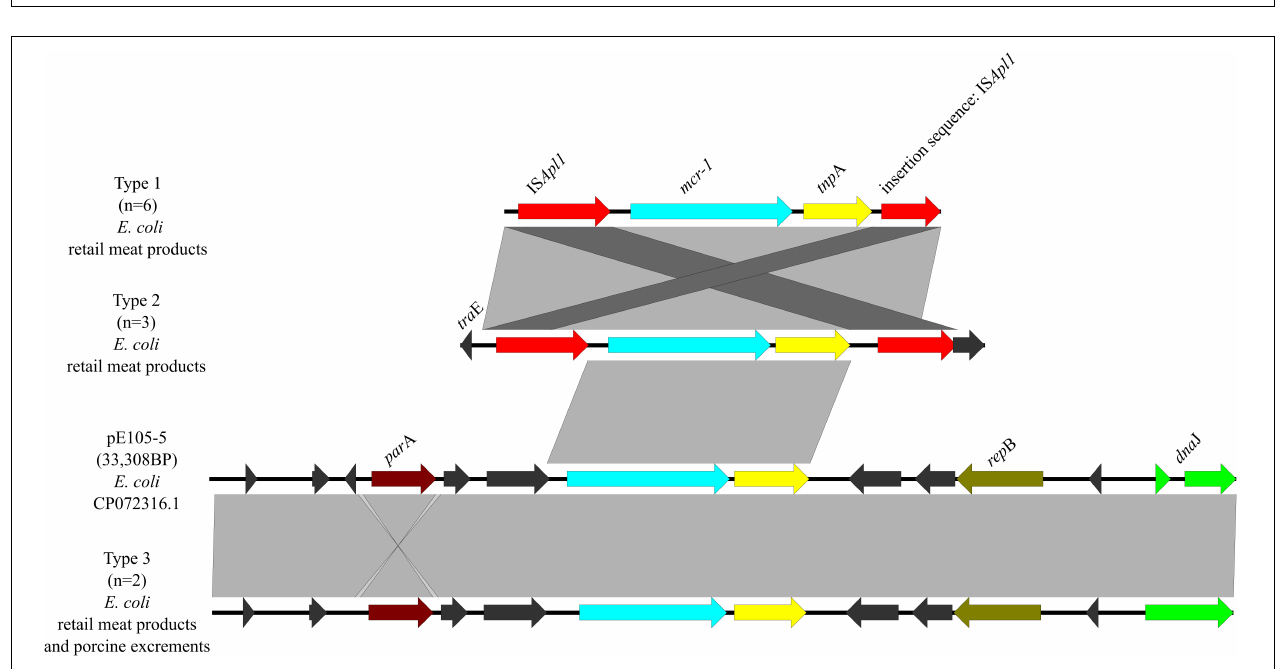
FIGURE 8 | Genetic environments of bla KPC − 2 in plasmids. Arrows indicate the direction of transcription of the genes, and different colors indicate different genes. Regions of ≥ 99.0% nucleotide sequence identity are shaded gray.